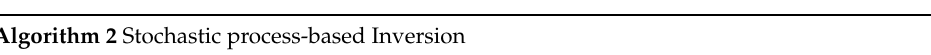
Algorithm 2 Stochastic process-based